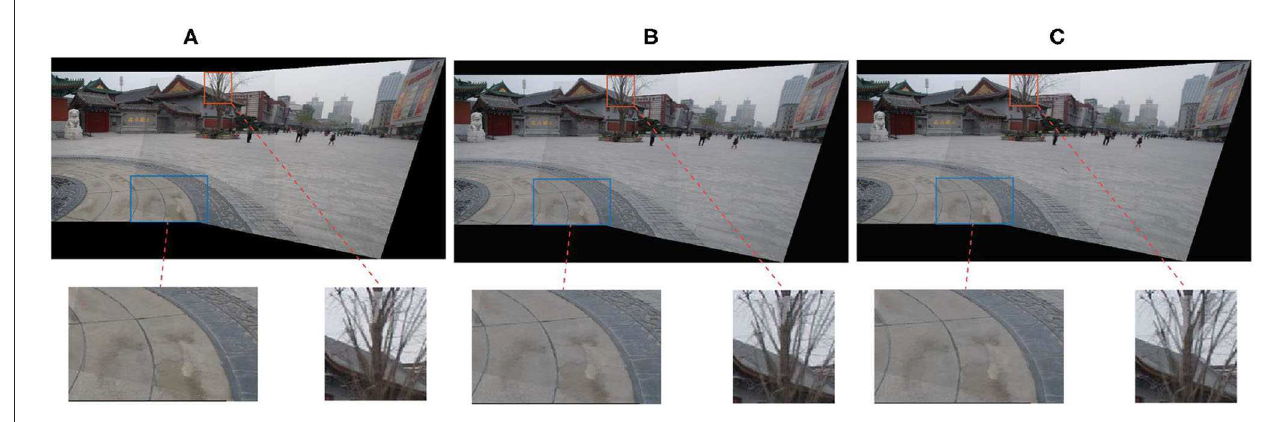
FIGURE3 Comparison of stitching results with different ω G . (A) ω G = 0, (B) ω G = 10, and (C) ω G =